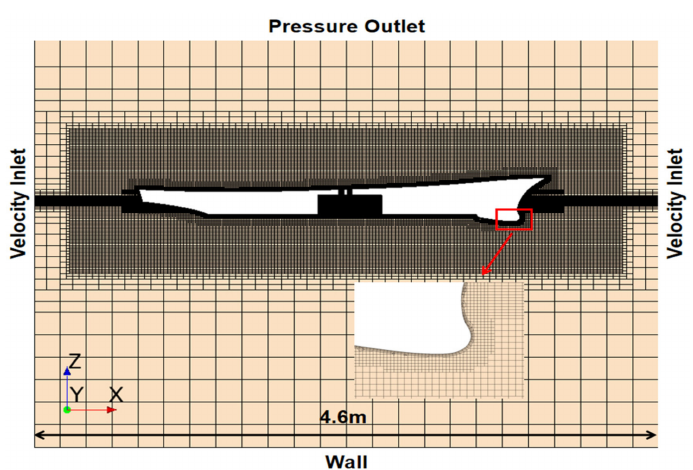
Figure 3. Mesh and boundary conditions (front view).